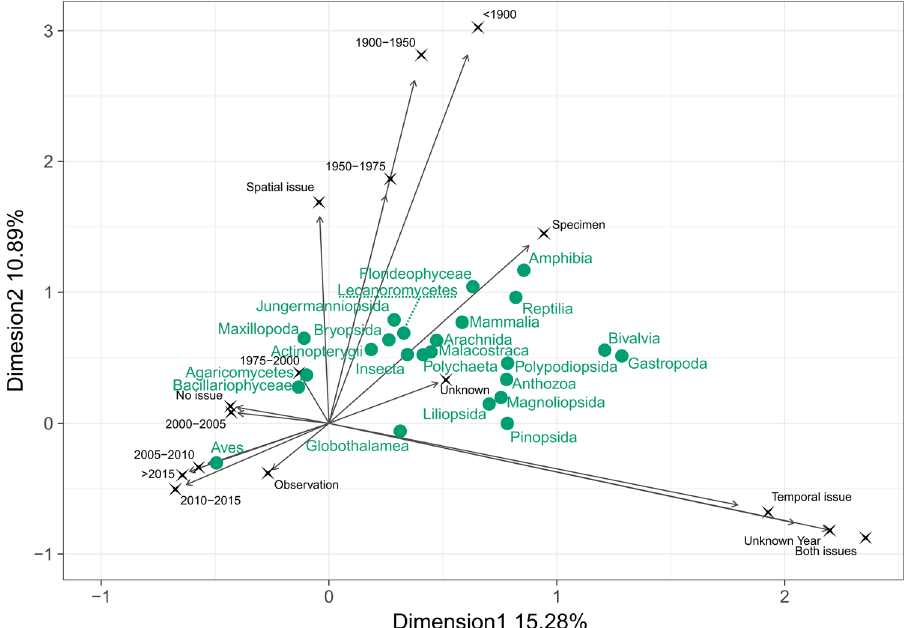
Figure 5. Relation between age, origin and quality of the occurrence data for 24 taxonomic classes. Graph showing the first two axes of a Multiple Correspondence Analysis (MCA) performed on 5 million random occurrences. Labels in black represent the categories considered for all occurrences. Classes’ names (in green) are placed at the average position of the class occurrences. Occurrence age contains eight time intervals and an Unknown Year category; data origin contains three categories: Specimen for specimen-based occurrences, Observation for observation-based occurrences, and Unknown for unknown origins; data quality contains four categories: Temporal issue for the lack of year or month, Spatial issues for the lack of coordinates, Both issues and No issue